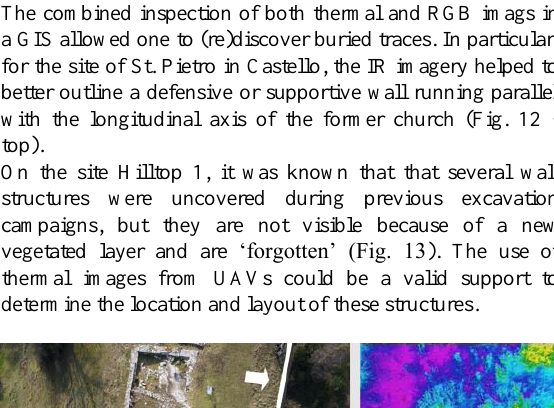
Fig. 11. RGB and thermal orthophoto for St. Pietro in Castello derived from an multi-image affine-based Least Squares adjustment ( level 2 ).